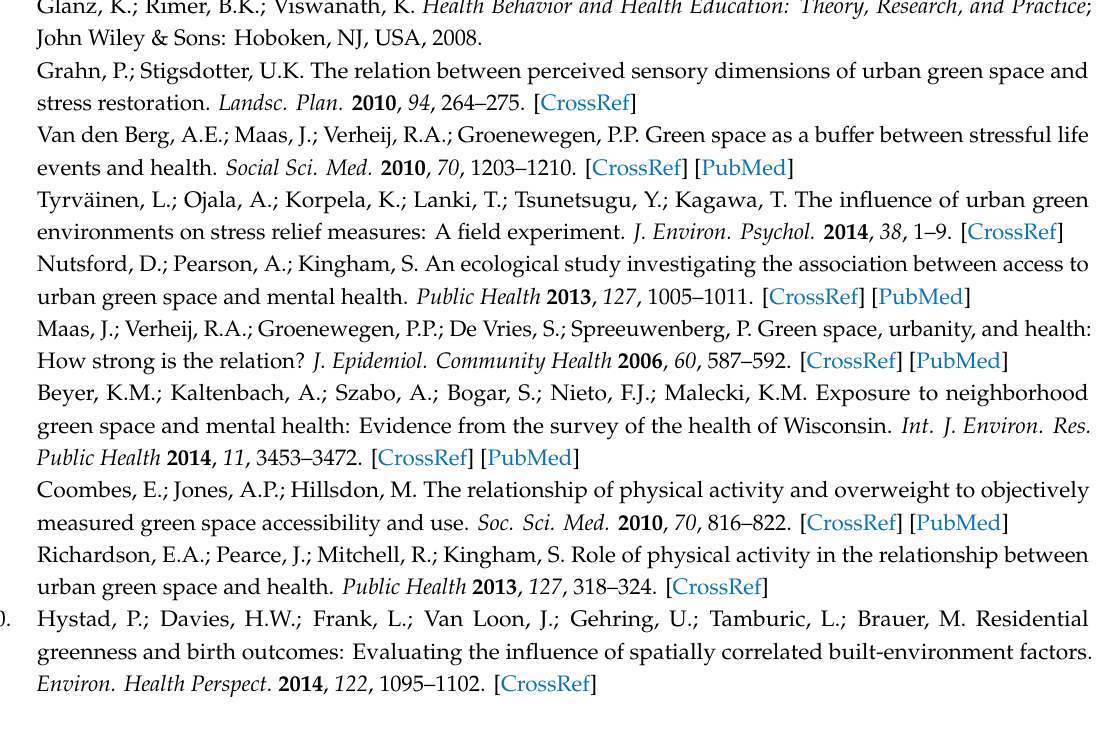
increase in NDVI on low birth weight, Table S15: Extracted data and e ff ect size computations for meta-analysis on small for gestational age, Table S16: E ff ect size computations for meta-analysis on small for gestational age based on 10% increase in green space proxies, Table S17: Meta-analysis results for the e ff ect of 10% increase in green space proxies, Table S18: E ff ect size computations for meta-analysis on small for gestational age based on 0.1 unit increase in NDVI, Table S19: Meta-analysis result for the e ff ect of 0.1 unit increase in NDVI on small for gestational age, Table S20: Extracted data and e ff ect size computations for meta-analysis on preterm birth LCI- lower 95% confidence interval, Table S21: E ff ect size computations for meta-analysis on preterm birth based on 10% increase in green space proxies, Table S22: Meta-analysis result for the e ff ect of 10% increase in residential greenness, Table S23: E ff ect size computations for meta-analysis on preterm birth based on 0.1 unit increase in NDVI, Table S24: Meta-analysis results of the e ff ect of 0.1 unit increase in NDVI on preterm birth, Table S25: Meta-Analysis Results for the e ff ect of NDVI increase on term birth weight, Table S26: Meta-Analysis Results for the e ff ect of NDVI increase on birth weight that are adjusted for gestational age, Table S27: Meta-Analysis Results for the e ff ect of NDVI increase on term low birth weight, Table S28: Meta-Analysis Results for the e ff ect of NDVI increase on low birth weight that are adjusted for gestational